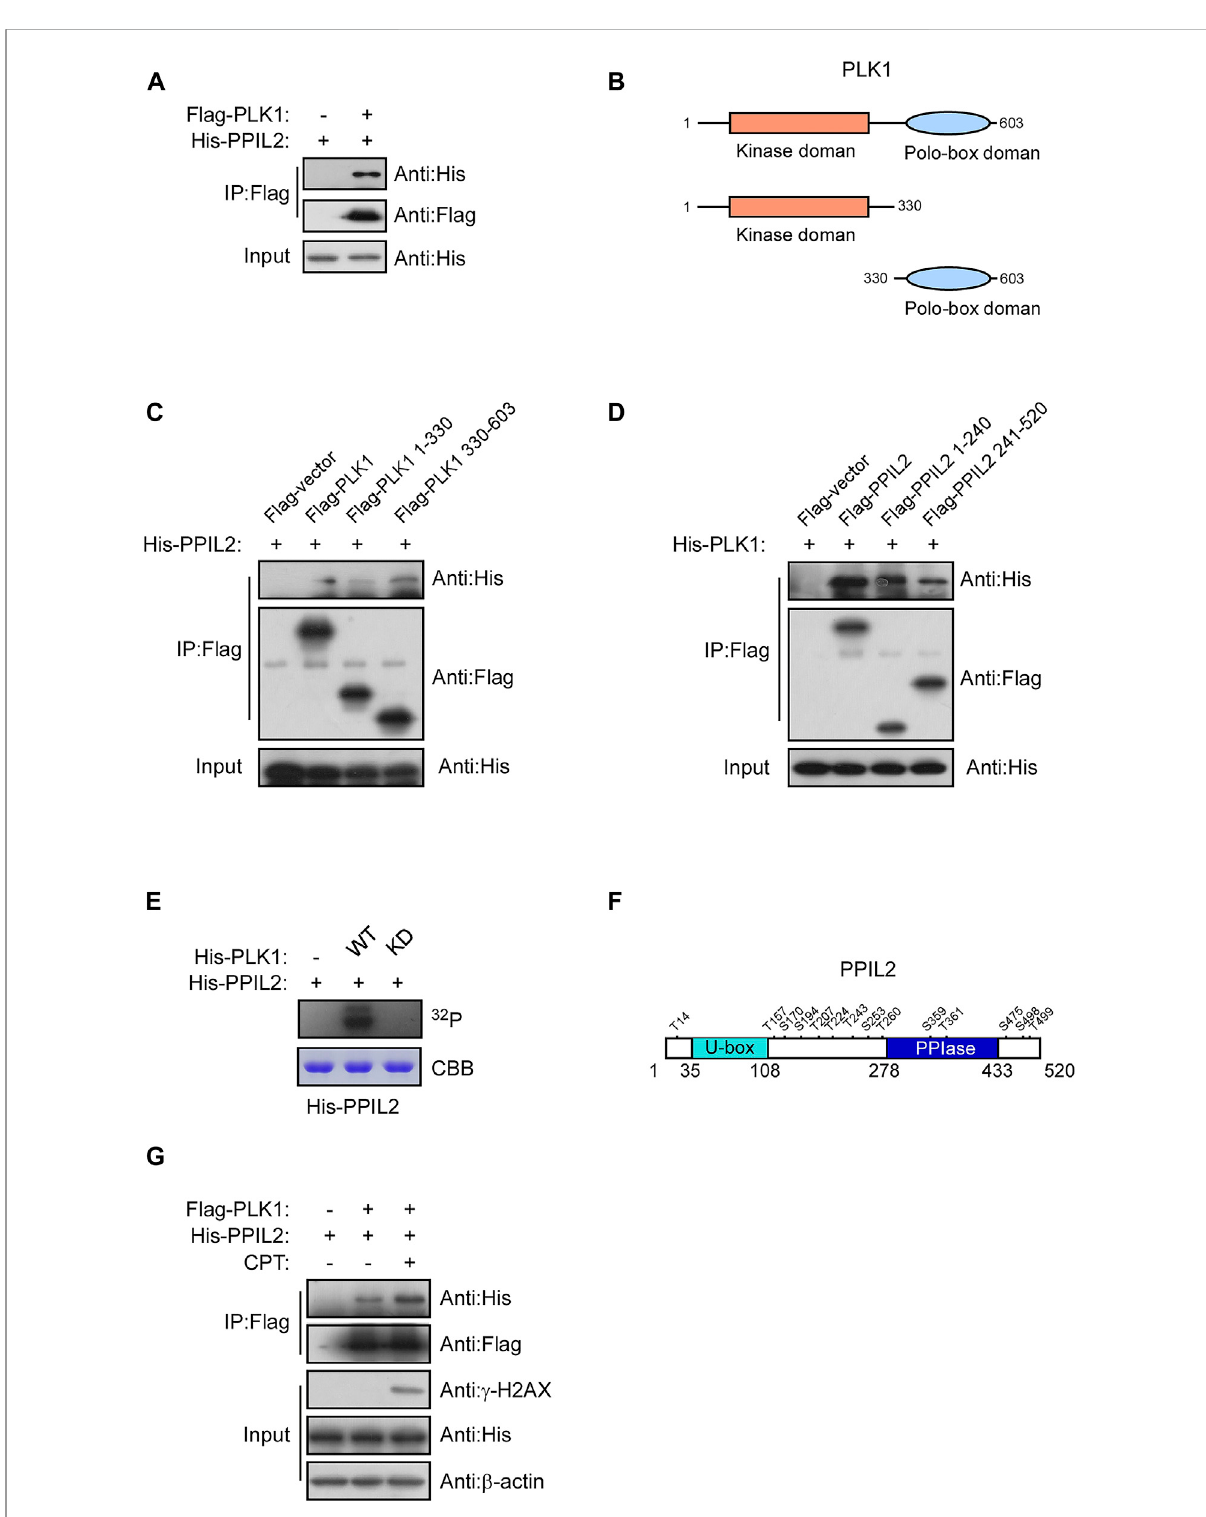
FIGURE 5 PLK1 interacts with and phosphorylates PPIL2. (A) 293T cells were cotransfected with Flag-PLK1, and His-PPIL2 expression constructs. IP and western blotting were performed with the indicated antibodies. (B) Schematic diagram of various PLK1 fragments. (C) 293T cells were cotransfected with Flag-PLK1 fragments and His-PPIL2, followed by IP with Flag and analysis by western blot. (D) 293T cells were cotransfected with Flag-PPIL2 fragments(seeFigure1C)andHis-PLK1,followedbyIPwithFlagandwesternblotanalysis. (E) Puri fi edHis-PPIL2wasincubatedwith[ γ - 32 P]ATP